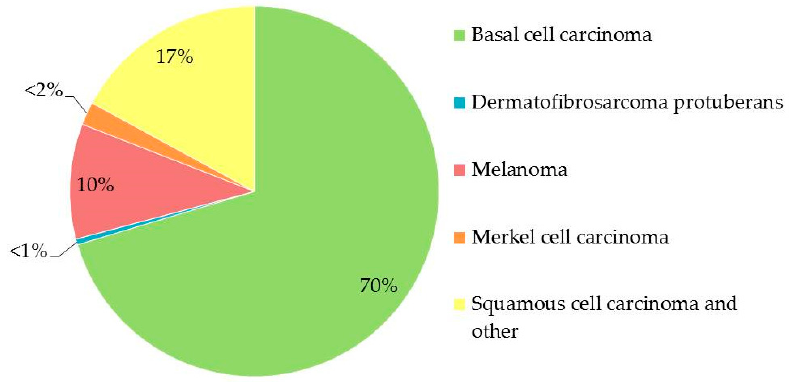
Figure 1. Incidence of different types of skin cancer.